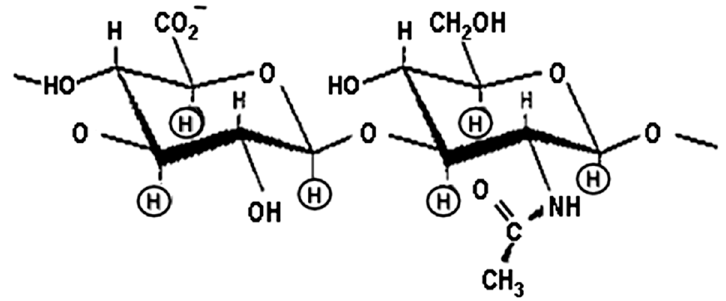
Figure 1. Illustration of the structure of hyaluronan (HA).